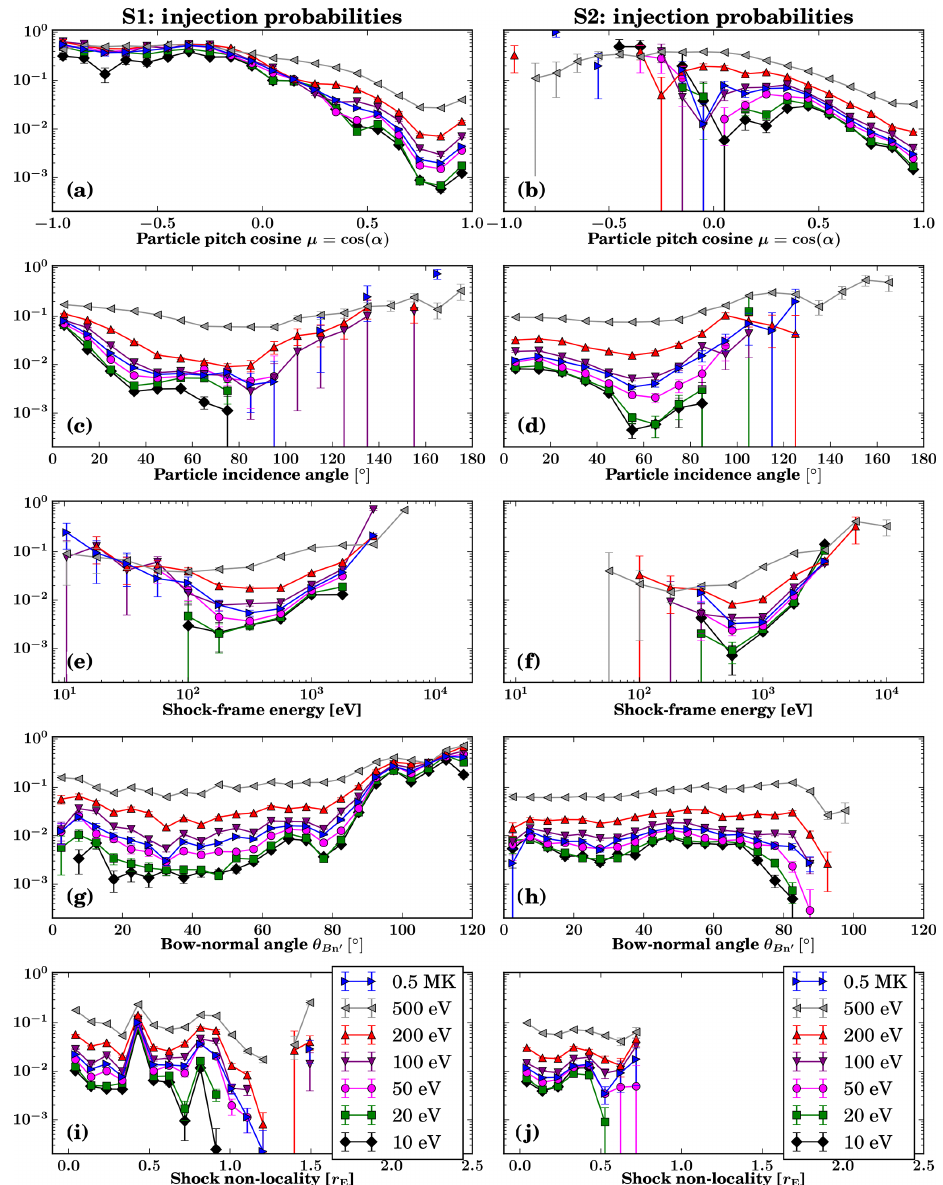
Figure 6. Test-particle injection probabilities for six different solar wind frame initialization energies and a 0.5MK Maxwellian initialization and five different parameters. Left column: S1. Right column: S2. Rows 1 through 3 (a–f) show properties of particles, namely the pitch- cosine µ = cos (α) , the incidence angle, and the shock-frame energy. Rows 4 and 5 (g–j) show shock properties, namely the local bow- normal angle θ Bn (cid:48) and the local shock non-locality. Displayed values were taken at the first encounter of each particle with the condition T core > 4 T core , sw . Error bars are provided by the Agresti–Coull method with a 95% confidence